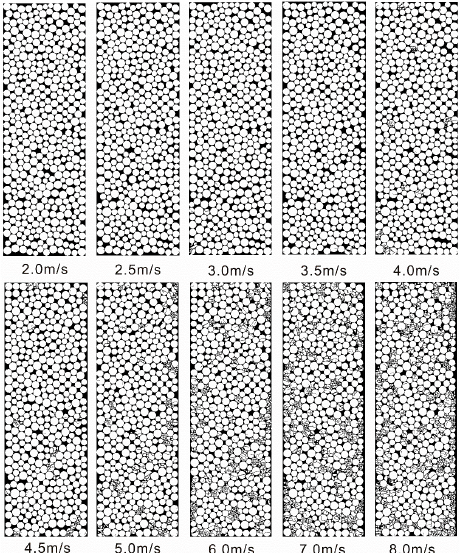
Figure 7. The configuration change of the filled particles after loading by the stress waves with different PPVs.